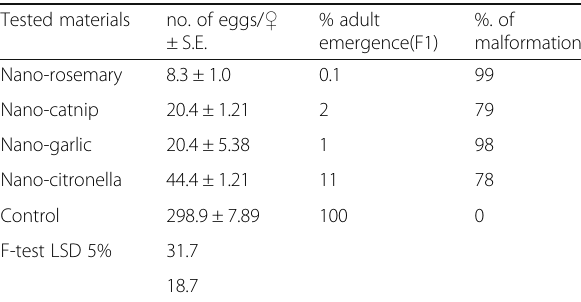
Table 6 Effect of tested oil nano-oils on number of laid eggs/ female and % of adult emergence (F1) of C. chinensis during storage periods